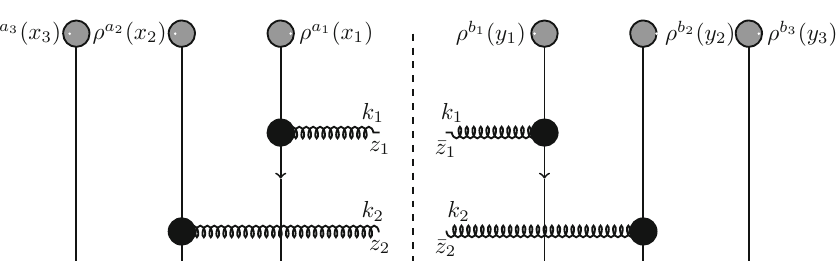
Fig. 5 Graphical illustration of Eq. (34) with the vertical lines representing the rescatterings with the target through Wilson